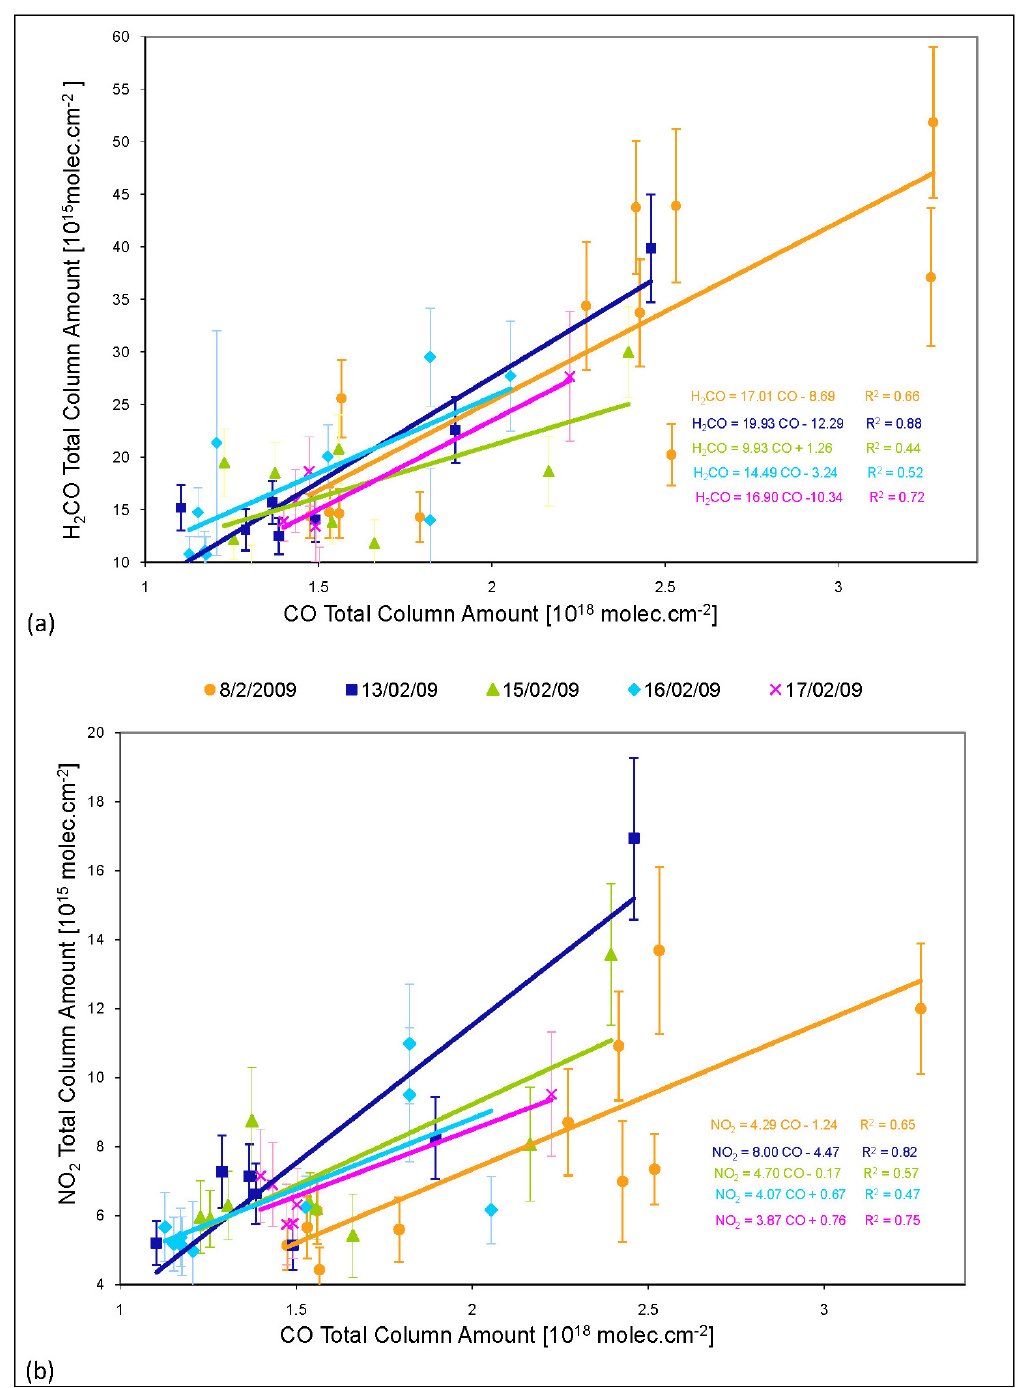
Figure 1. OMI total column amounts of ( a ) H AIRS CO total column amount measurements within smoke from the active Victorian fires on various days during February 2009. Each point on the plots corresponds to an average total column amount for a particular 1° latitude by 1° longitude grid space over